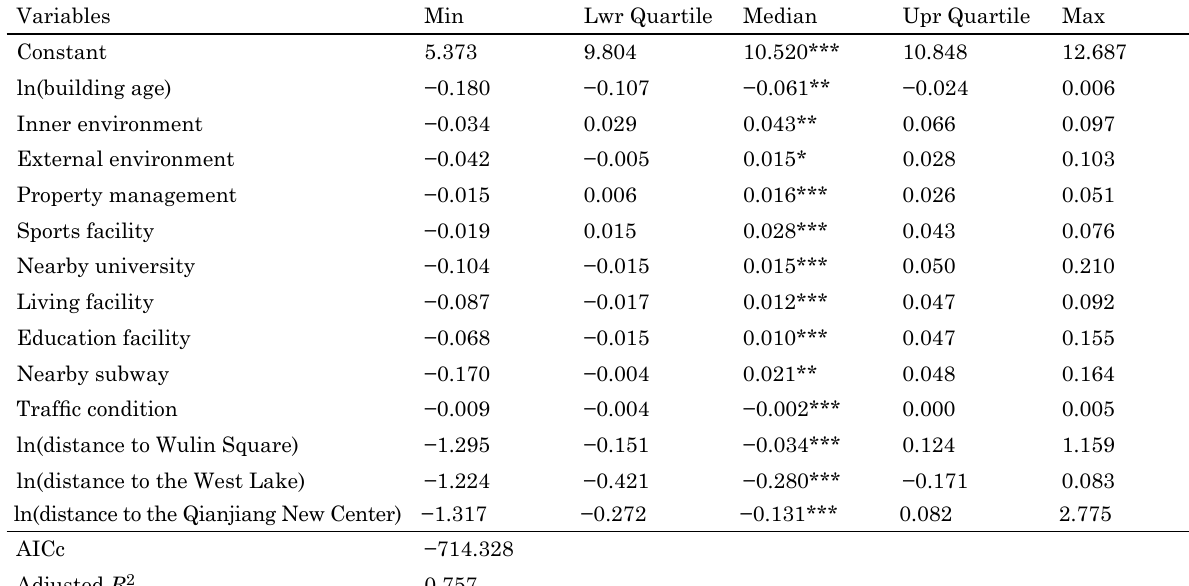
Table 4. Results of GWR